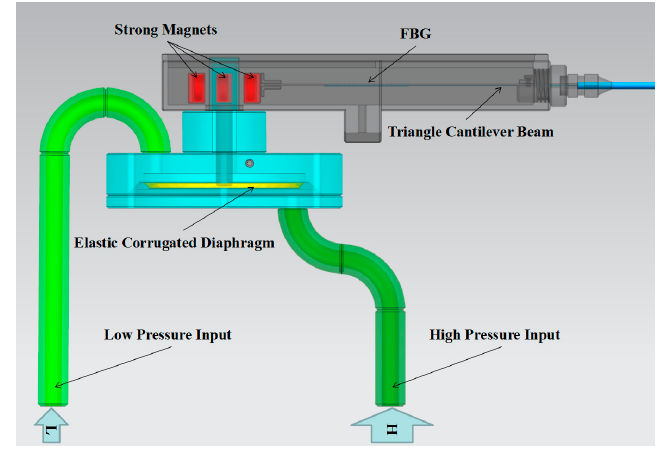
Figure 2. The structure of the FBG-based differential pressure sensor with magnetic transfer.